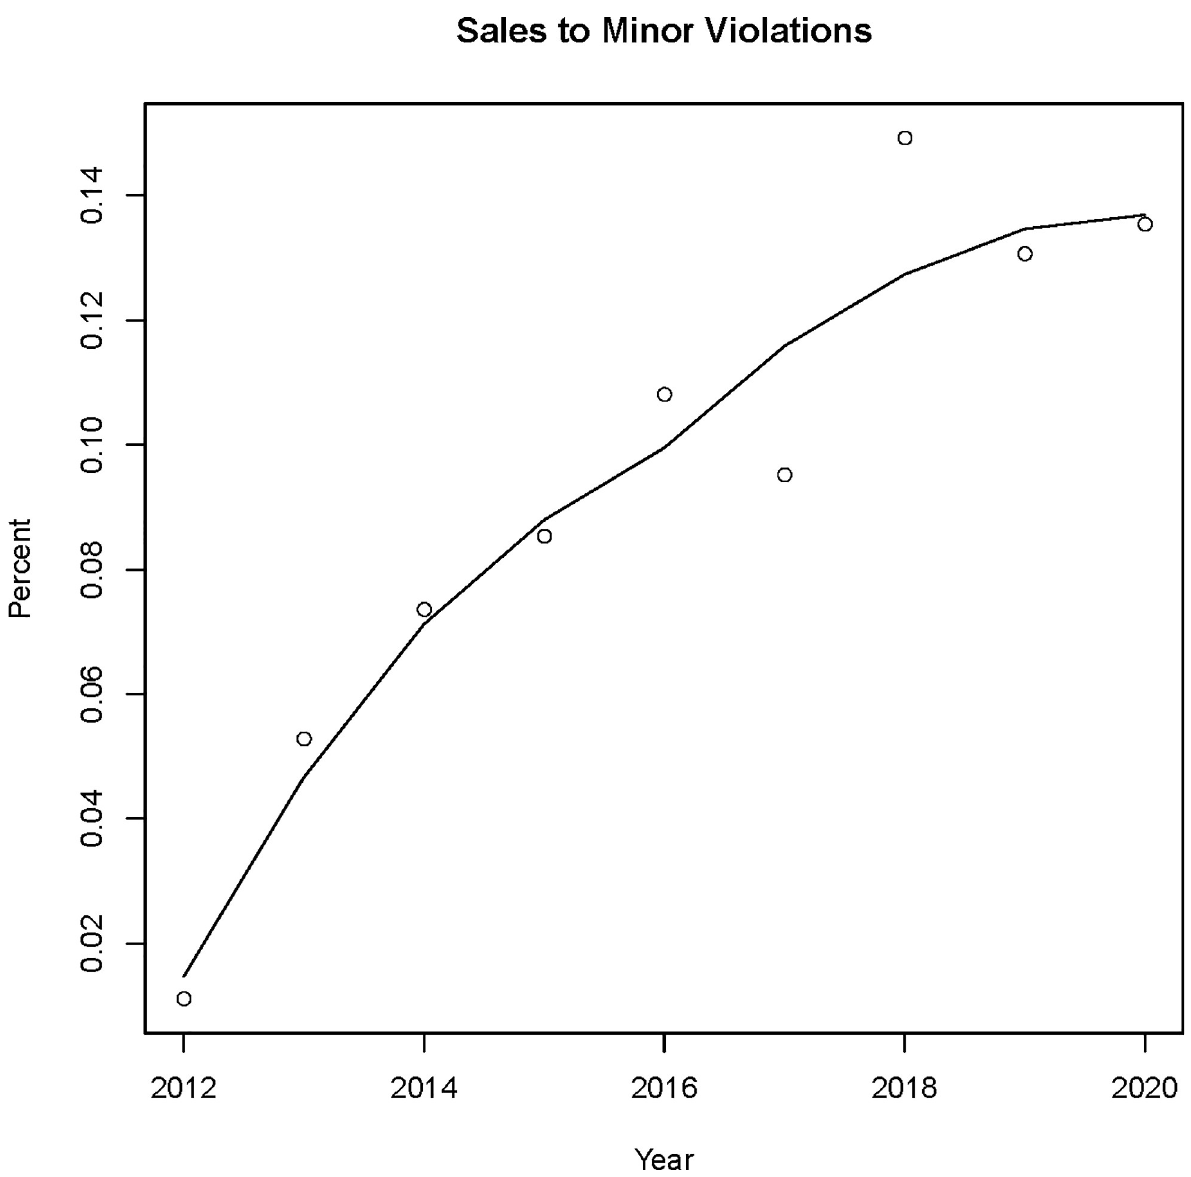
Fig 1. Percent of compliance check visits with a violation for a sale to a minor by year in 2012–2020 with a loess best fit